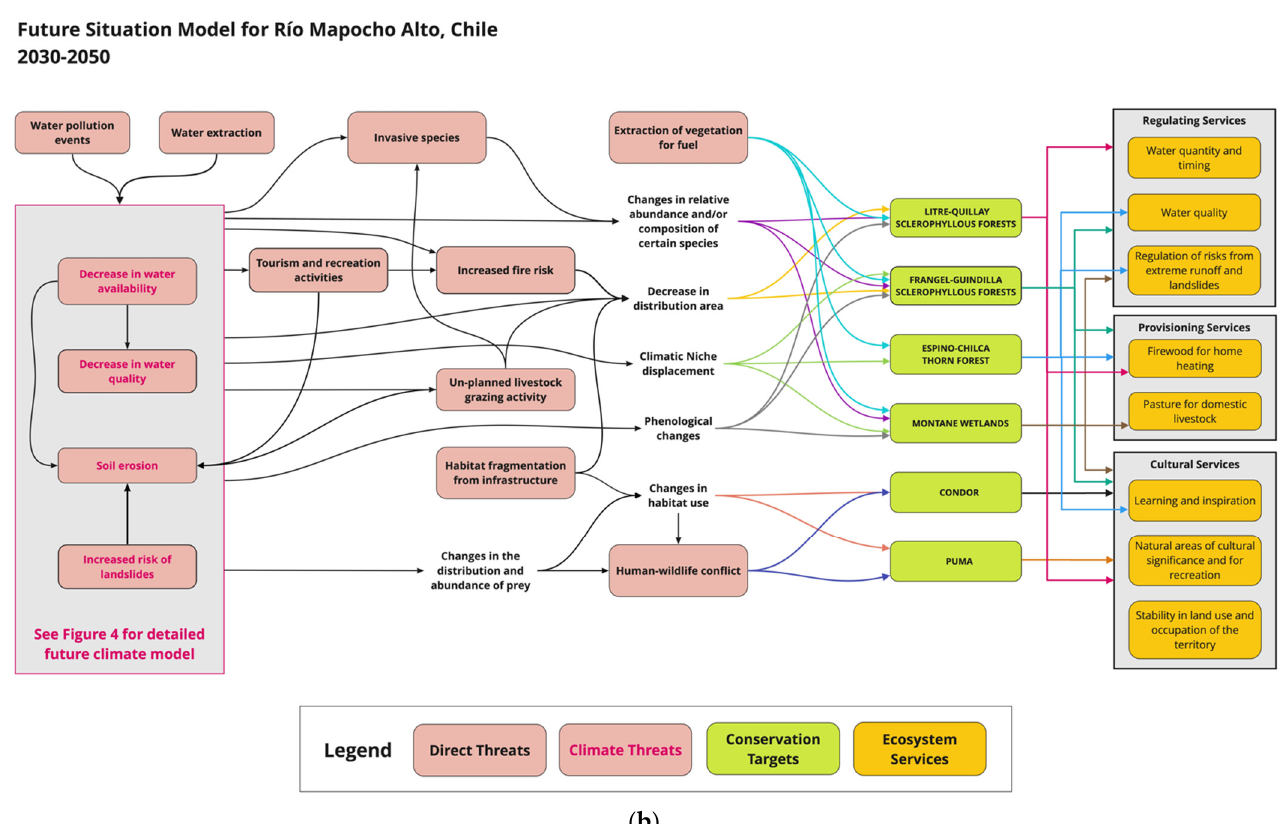
Figure 5. Future Situation Models for ( a ) Tugai Nature Reserve in Central Asia (adapted with permission from ref. [25]) and ( b ) Río Mapocho Alto watershed in Chile.